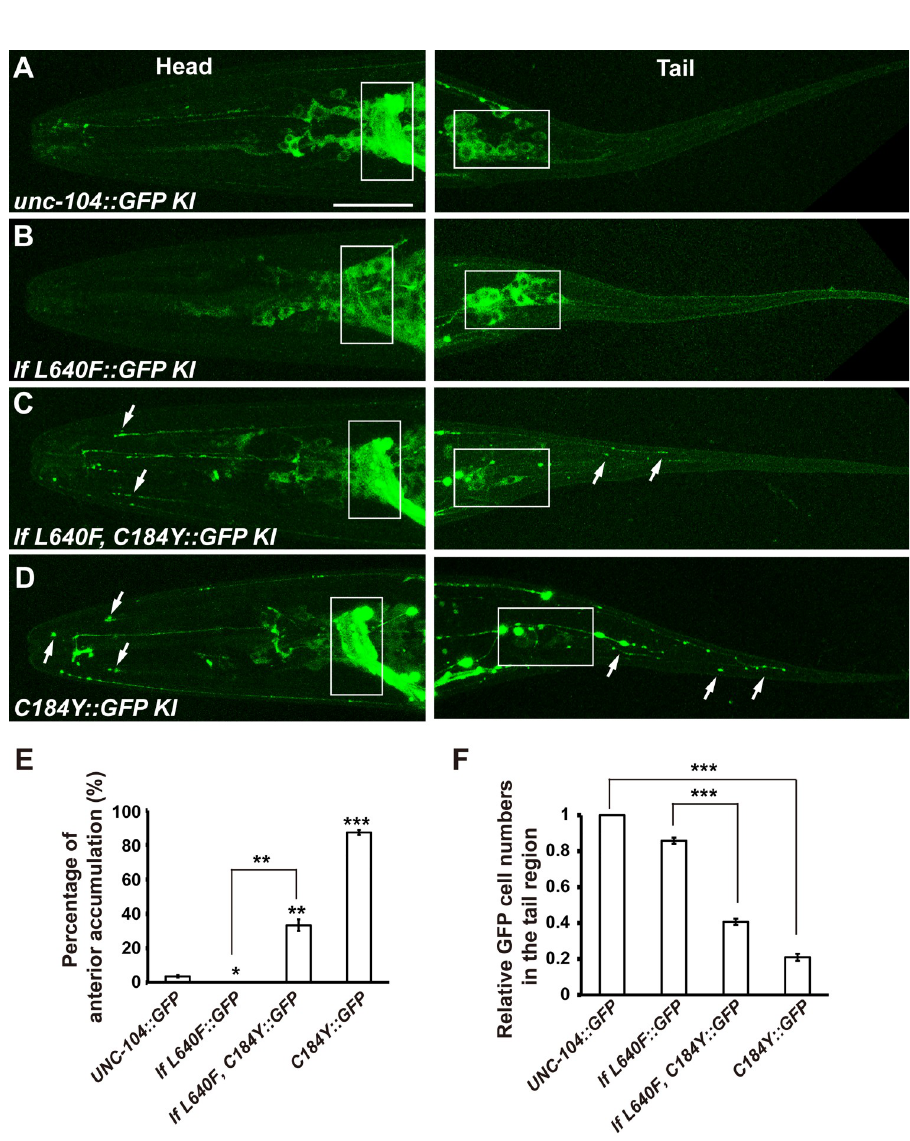
Fig 4. Endogenous localization of wild-type and mutant UNC-104motors. (A and B) The wild-type and UNC-104 lf L640F motor (GFP KI, green) are diffusely distributed in neuronal cell bodies and processes. (C and D) The UNC-104 lf 640F, C184Y and UNC-104 C184Y motor (GFP KI, green) tend to accumulate on neuronal processes and are generally absent from neuronal cell bodies. Boxes indicate part of the ring ganglion (left) or pre-anal ganglion (right). White arrows indicate some of the neuronal termini. Scale bar represents 25 μ m. (E) Quantification of the percentage of animals showing anterior accumulation of GFP signal. � P < 0.05, �� P < 0.01, ��� P < 0.001, one-way ANOVA with Tamhane’s T2 test. 300 worms were observed for each genotype. Mean ± SEM, N = 6. (F) Quantification of the GFP positive cells in the tail region. ��� P < 0.001, one-way ANOVA with Tamhane’s T2 test. Mean ± SEM, N = 30.